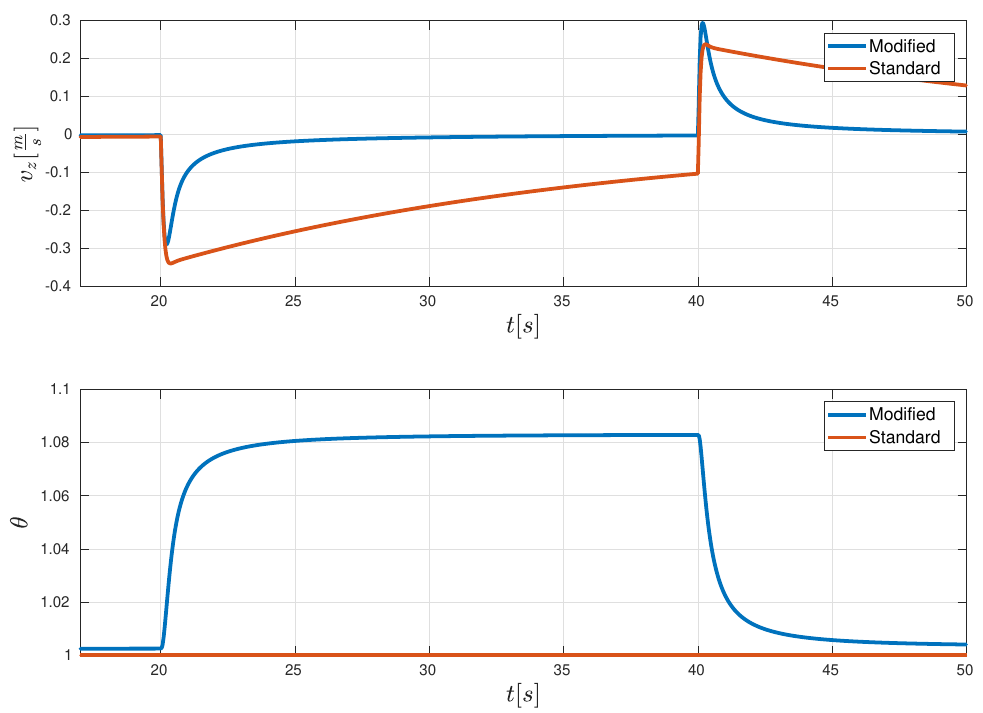
Figure 7. Simulation of the difference of the additive PID